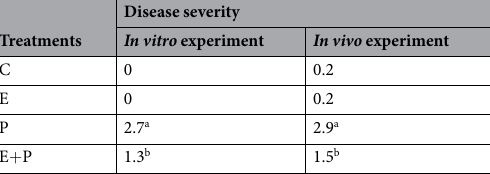
Table 3. Calculation of disease severity index in Crocus plants. Where, C stands for control (endophyte free plants), E stands for only endophyte (CS10E4) treatment, P stands for only pathogen ( F. oxysporum R1) treatment, E + P stands for pathogen treatment after 3dpi of endophyte treatment. Analysis of variance (ANOVA) of disease severity among the four treatments was tested by Bonferroni test at a significance level of p ≤ 0.05 using GraphPad InStat tm software (V2.05). a Are means significantly different from C and E at